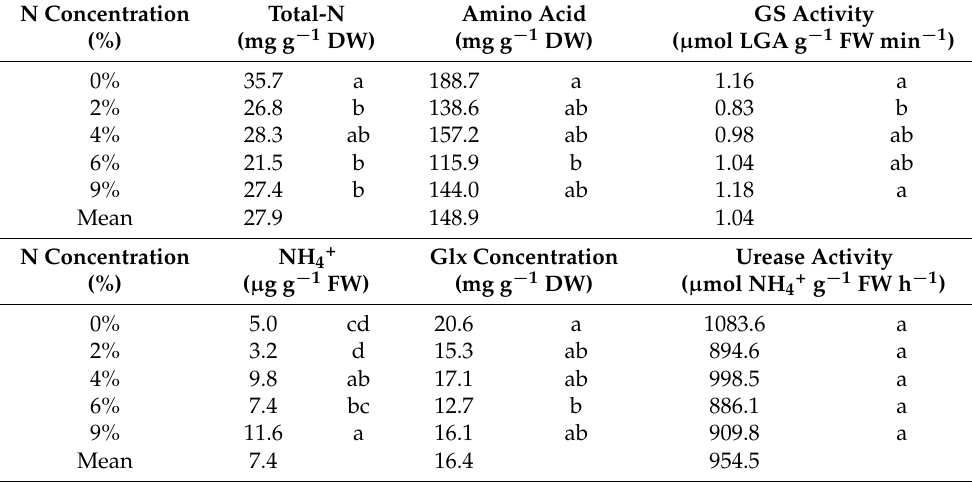
Table 1. Total-N, amino acid, NH 4+ , and glutamate + glutamine (Glx) concentration as well as urease, and glutamine synthetase (GS) activity in the YFEL of spring wheat (cv. Harenda) foliar fertilized with different urea-N concentrations at 7 DAFNf.